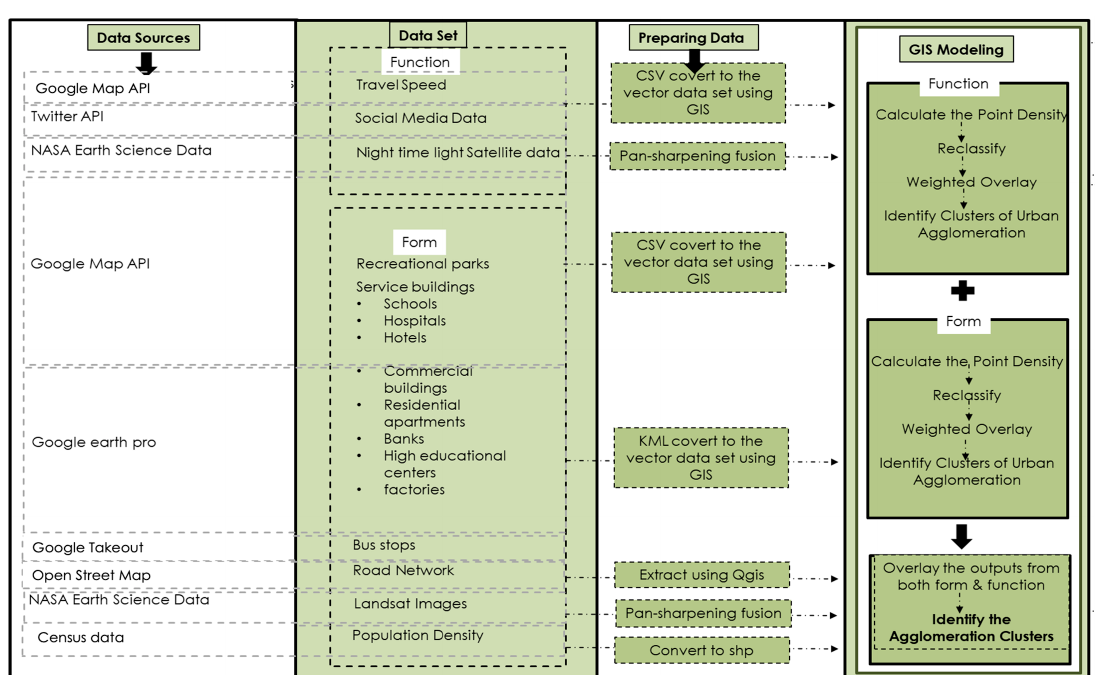
Figure 3. Methodological framework.